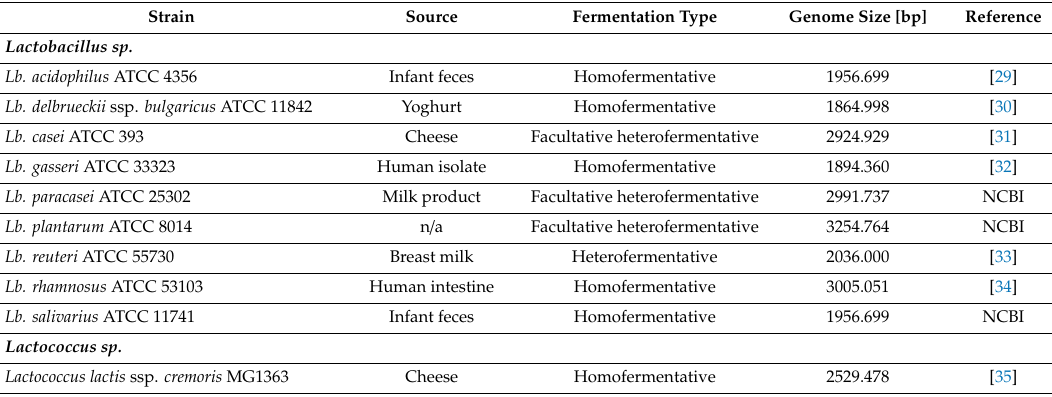
Table 1. Bacterial strains used in this study, and some of their properties.